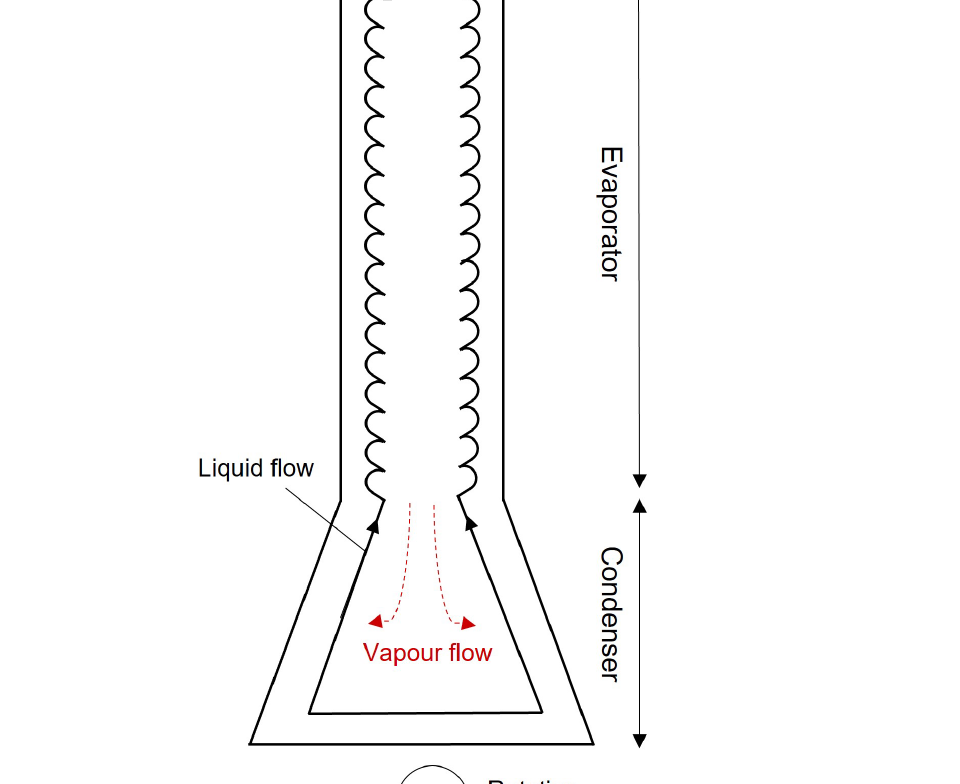
air and heat pipe-cooled disk with 60 blades on the top. The air cooling was modeled via a simple single channel running through the blade and part of the disk. Heat pipes were simplified as solid rods with thermal conductivity ranging from 10 to 50 kW/m/K, arranged circumferentially, and extended in the radial direction. The TIT was 1700 K. They fixed the distance between the top of the heat pipes and the disk rim while extending the pipe length radially inward to the disk center. With increasing heat pipe length, the disk rim